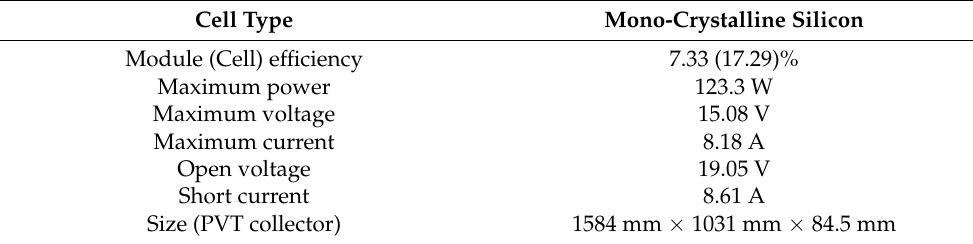
Table 1. Specifications of PV used for air-type PVT collector. From